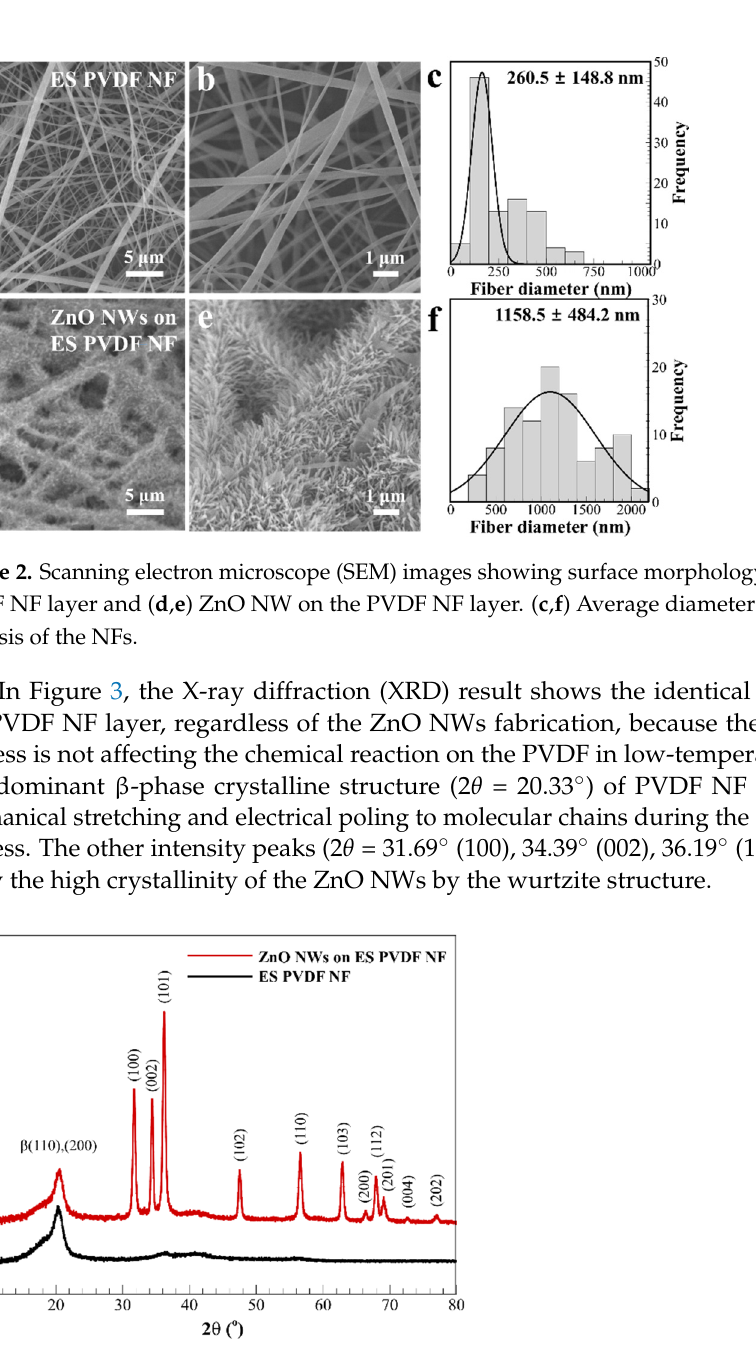
Figure 3. X-ray diffraction analysis results of electrospun PVDF NF layer, with and without ZnO NWs. A solar simulator was used as a light source of 1/4 sun intensity (24 mW cm − 2 ).